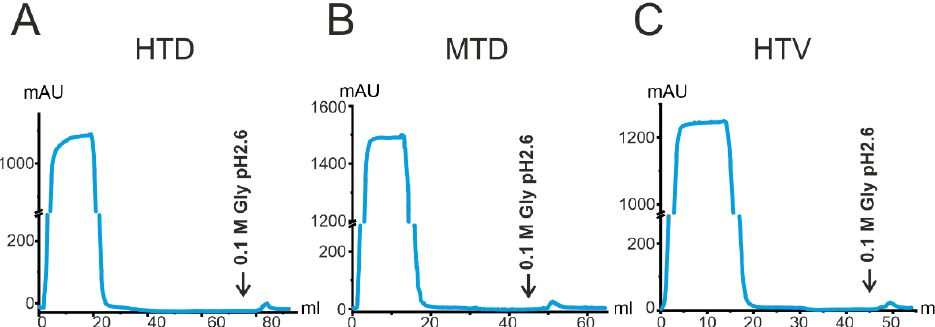
Figure 3. Isolation of S*-IgG by affinity chromatography on S-Sepharose from the IgG antibody preparation, after chromatography on RBD-Sepharose. Patient groups: ( A ) HTD, ( B ) MTD, ( C ) HTV. Elution of antibodies was performed with 0.1 M Gly-HCl pH 2.6.